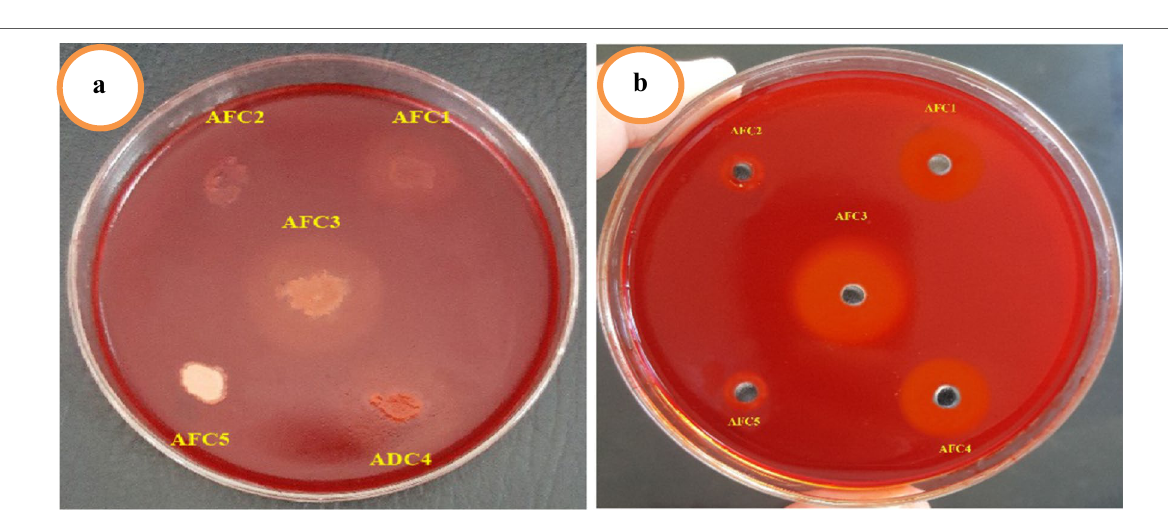
Fig. 2 The ability of the isolates to degrade CMC by spotte ( a ) and well ( b ) diffusion assay